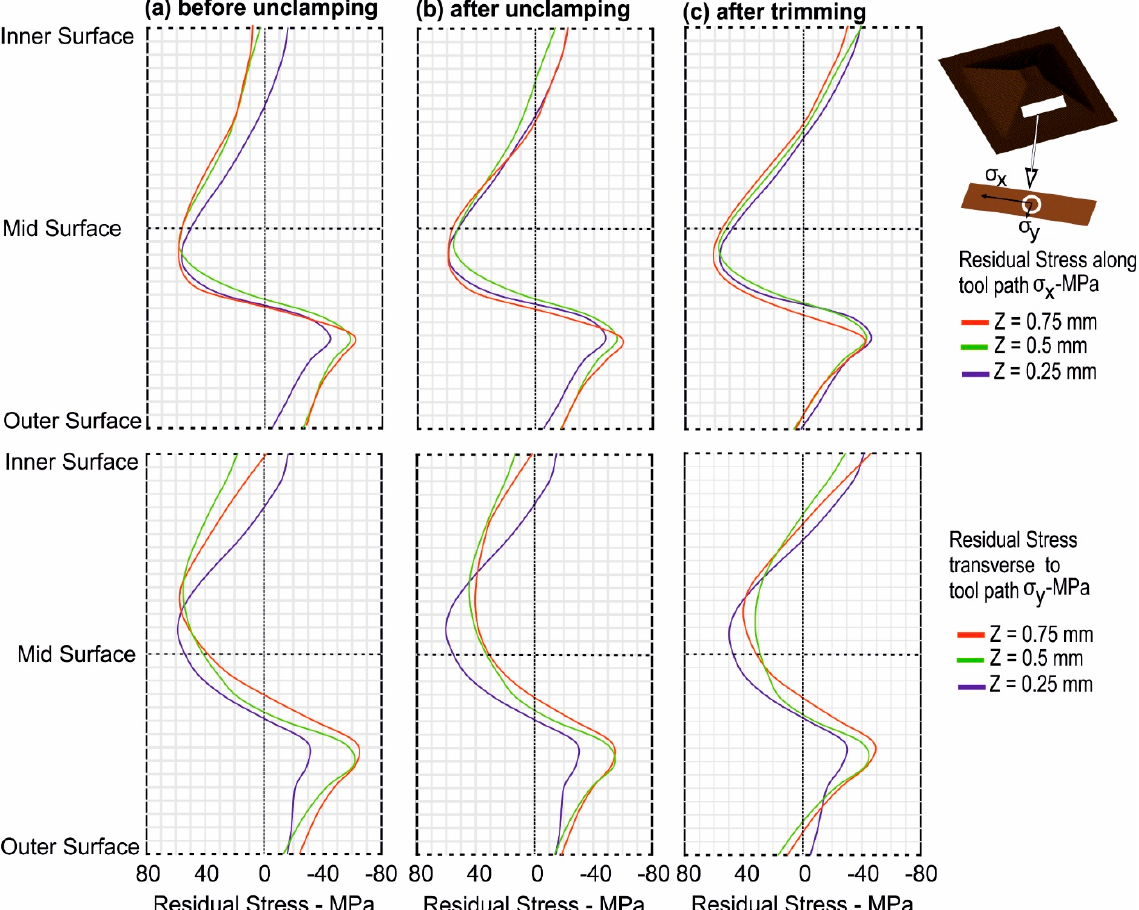
Figure 9. Distribution of the residual stresses in the center of the strip along and in the transverse direction of the tool motion for different tool step-down values ( a ) before unclamping, ( b ) after unclamping, and ( c ) after trimming.